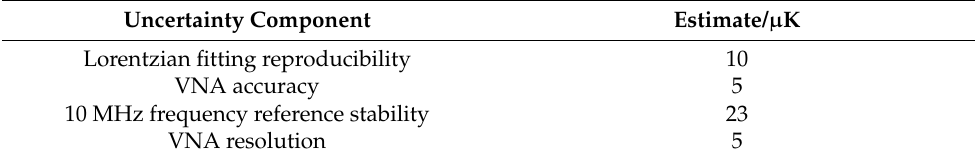
Table 3. Individual temperature uncertainty components due to frequency